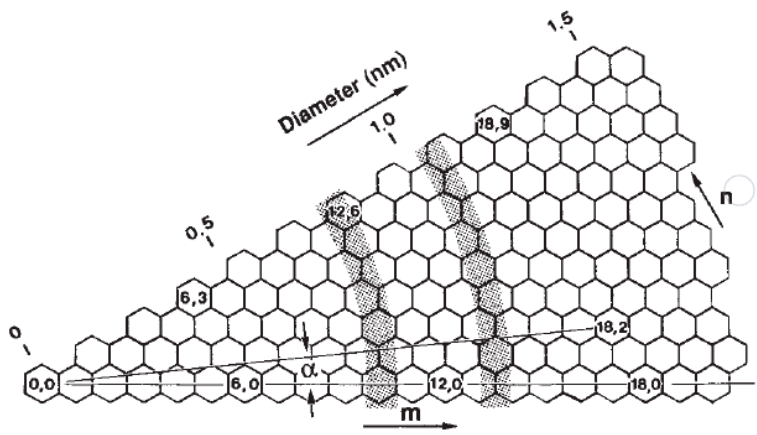
Figure 12. Schematic representation of different chirality indices resulted from different rolled-up vector for honeycomb graphene structure [143]. Reproduced with permission from Lijima and Ichihashi, Nature , published by Nature, 1993.